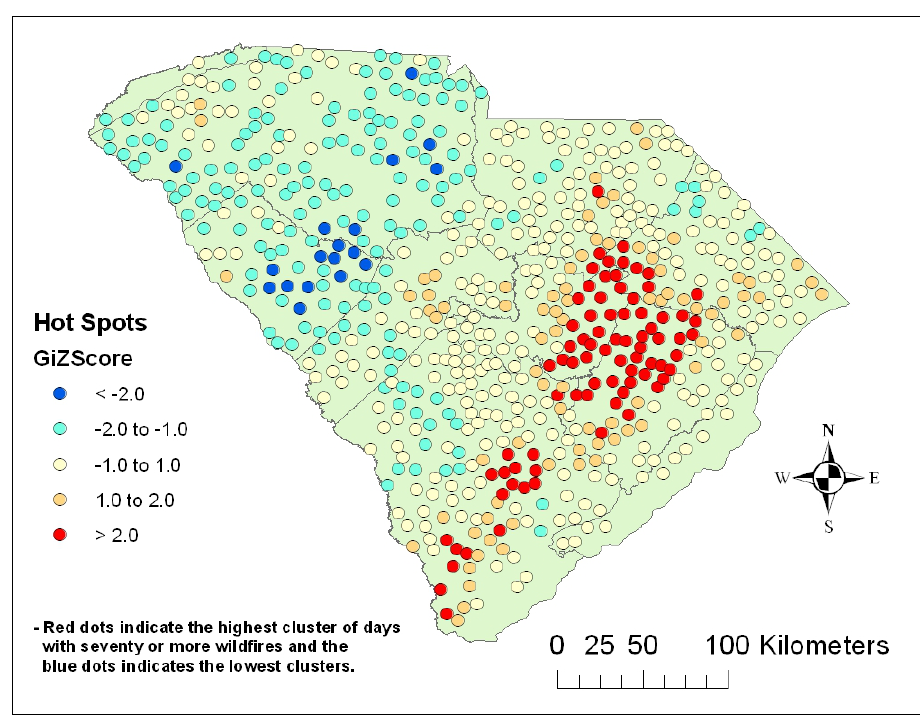
Figure 4. Hotspot analysis of days with seventy or more